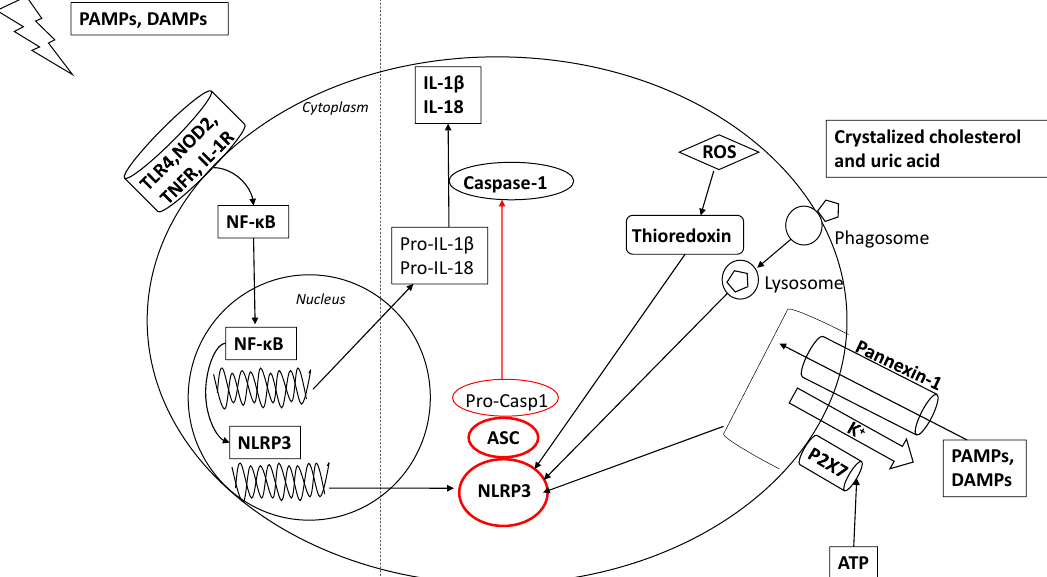
Figure 1. Two-step model of nucleotide-binding oligomerization domain (NOD)-like receptor pyrin domain-containing-3 (NLRP3) inflammasome activation. In the first step, pathogen-associated molecular patterns (PAMPs) and damage-associated molecular patterns (DAMPs) activate the nuclear factor (NF)- κB pathway through the stimulation of receptors such as toll-like receptor (TLR)4, nucleotide binding oligomerization domain-like receptor (NOD)2, tumor necrosis factor receptor (TNFR), and interleukin (IL)-1R. In addition, NF- κB activates NLRP3 gene transcription. The second step involves various concomitant molecular mechanisms. Extracellular ATP induces P2×7-dependent pore formation on the cell membrane, which allows K+ efflux depletion and opening a pannexin-1 channel, through which PAMPs and DAMPs enter in the cell, activating NLRP3. Endocitosis of dissimilar agonists, including crystalized cholesterol and uric acid, results in lysosomal disruption, which also leads NLRP3 activation. Additionally, reactive oxygen species (ROS) leads to thioredoxin dissociation, which binds to the NLRP3 inflammasome to trigger its activation. The NLRP3 inflammasome is composed of an inflammasome sensor NLRP3, apoptosis-associated speck-like protein containing a CARD (ASC) and the precursor pro-caspase1: when activated, NLRP3 components cause the activation of caspase-1, which leads to the maturation and secretion of proinflammatory cytokines including IL- 1β and IL -18.